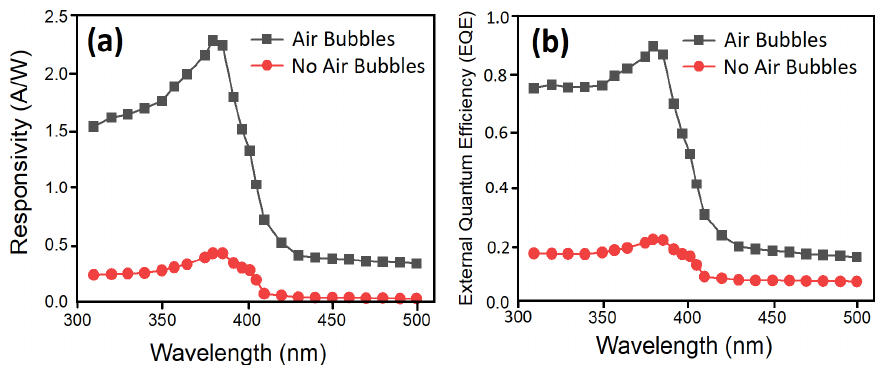
Figure 18. ( a ) Spectral responsivity and ( b ) external quantum efficiency (EQE) of the fabricated UV PDs as a function of incident light source wavelength with no air bubbles and with air bubbles at fixed 5 V bias voltage and under 0.61 mW/cm 2 UV light illumination.